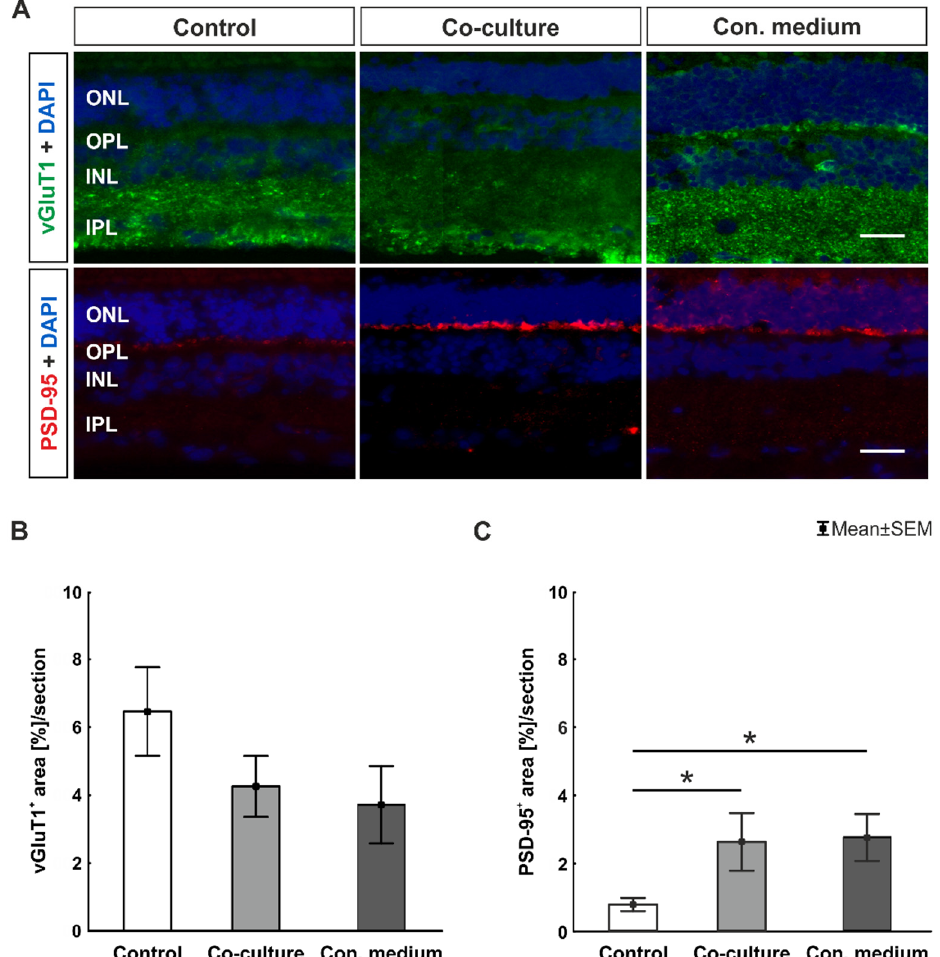
Figure 4. Unaltered synaptic density in cultivated retina. ( A ) To label the uptake of glutamate into synaptic vesicles at presynaptic nerve terminals, vGluT1 antibody was used (green). Whereas the PSD-95 antibody (red) stained the postsynaptic terminals. Cell nuclei were labeled with DAPI (blue). ( B ) vGluT1 + signal area was not altered in co-culture or conditioned medium groups compared to controls. ( C ) More PSD-95 + signal area was observed in the co-culture ( p = 0.049) and conditioned medium group ( p = 0.022) compared to controls. ONL, outer nuclear layer; OPL, outer plexiform layer; INL, inner nuclear layer; IPL, inner plexiform layer. Scale bar: 20 µm, values are presented as mean ± SEM, n = 8/group, * p < 0.05.